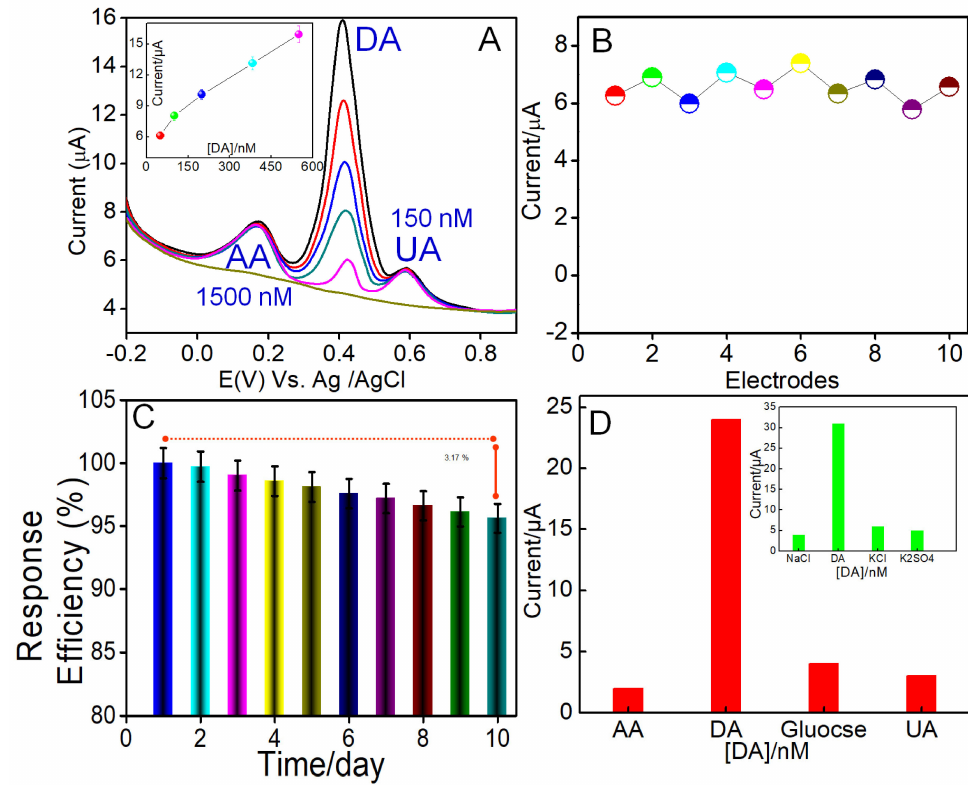
Figure 5. DPVs of SNPO-CPL-800 toward selective signaling of ( A ) DA with increasing concentration range 0.05 to 0.55 µ M in the presence of constant concentration of AA (0.15 µ M) and UA (1.5 µ M). Inset of A shows the respective calibration curve derived from their DPV curves. ( B ) Reproducible current response of 10 different SNPO-CPL-800 electrodes toward 50 nM of DA, ( C ) Long-term stability of the SNPO-CPL-800 based electrode for continuous 10 days towards electrochemical oxidation of fixed concentration (50 nM) of DA through DPV, and ( D ) Amperometric selective current response of SNPO-CPL-800 based electrode toward chicken sample containing 0.8 µ M of DA in the co-existence of 2 µ M of AA, UA, and glucose interferences at an applied potential of 0.39 V. Inset of F shows amperometric selective current response of SNPO-CPL-800 based electrode toward chicken sample containing 1.1 µ M of DA in the co-existence of 5 µ M of inorganic interferences such as NaCl, KCL, and K 2 SO 4 at an applied potential of 0.39